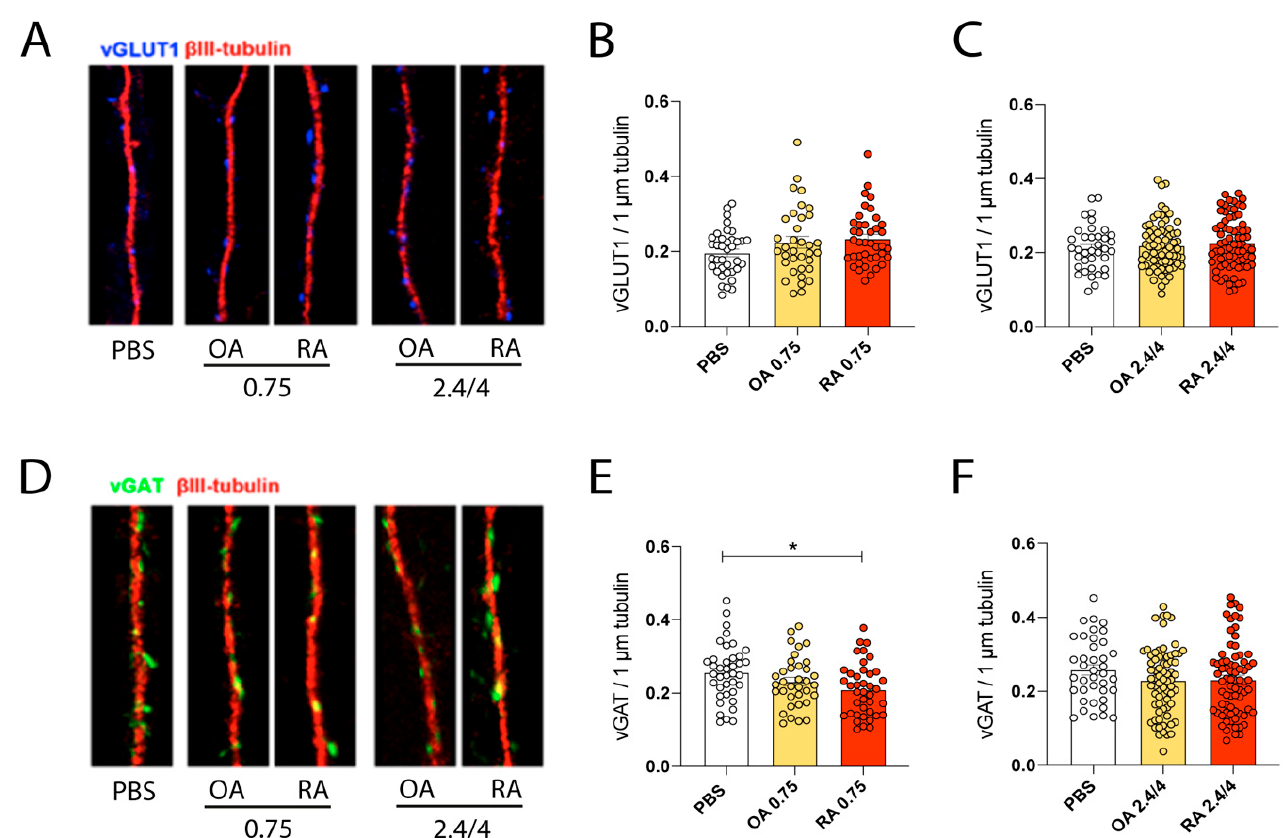
Figure 3. EVs collected from RA and OA synovial fluids lead to increased excitatory transmission but through opposite synaptic changes: confocal analysis. ( A ) Immunocytochemical experiments were performed in wt 14 DIV cultured hippocampal neurons against vGLUT1 (blue) and BIII tubulins (red) after two hours of exposure to OA- and RA-EVs. (B,C) Analysis of vGLUT1 density shows no differences among PBS and OA- / RA-EVs treated neurons, neither at low nor at medium/high concentration (low concentration: Kruskal–Wallis test followed by Dunn’s multiple comparison test, ns; field analysed for each condition: PBS = 37; OA = 35; RA = 40; medium/high concentration: Ordinary one-way ANOVA followed by Tukey’s multiple comparison test, ns; field analysed for each condition: PBS = 37; OA = 69; RA = 71). (D) Immunocytochemical experiments performed in wt 14 DIV cultured hippocampal neurons against vGAT (green) and BIII tubulins (red) after two hours of exposure to OA- and RA-EVs. (E,F) vGAT density was found increased after exposure to RA-EVs at low concentration; whereas no differences were revealed at medium/high concentration (low concentration: Ordinary one-way ANOVA followed by Tukey’s multiple comparison test, * p < 0.05; field analysed for each condition: PBS = 39; OA = 35; RA = 40; medium/high concentration: Kruskal–Wallis test followed by Dunn’s multiple comparison test, ns; field analyzed for each condition: PBS = 39; OA = 71; RA = 74).